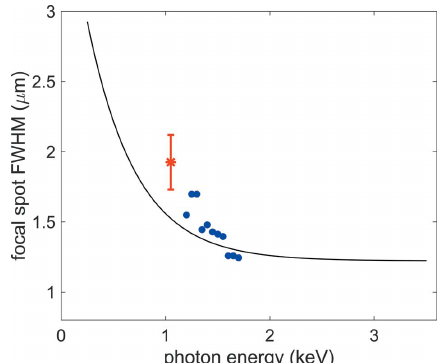
Figure 6 Black line: beam size (FWHM) as a function of photon energy estimated from the ray-tracing simulated intensity distribution under the assump- tion that the FEL source is located at the end of the last undulator, with no longitudinal extension. The simulations are performed accounting for the surface error of the mirrors and taking into account the diffraction effects, as described in the text. Red star: beam size from the WFS characterization, taken from the FWHM of the smaller Gaussian contribution to the double Gaussian fit of the 2D intensity distribution [see Figs. 3( c ) and 4( c )]. Blue dots: beam size from the CSD characterization, taken from the FWHM of the smaller Gaussian contribution to the double Gaussian model for the fluence distribution used to fit the CSDs collected as a function of photon energy, see Table 3.